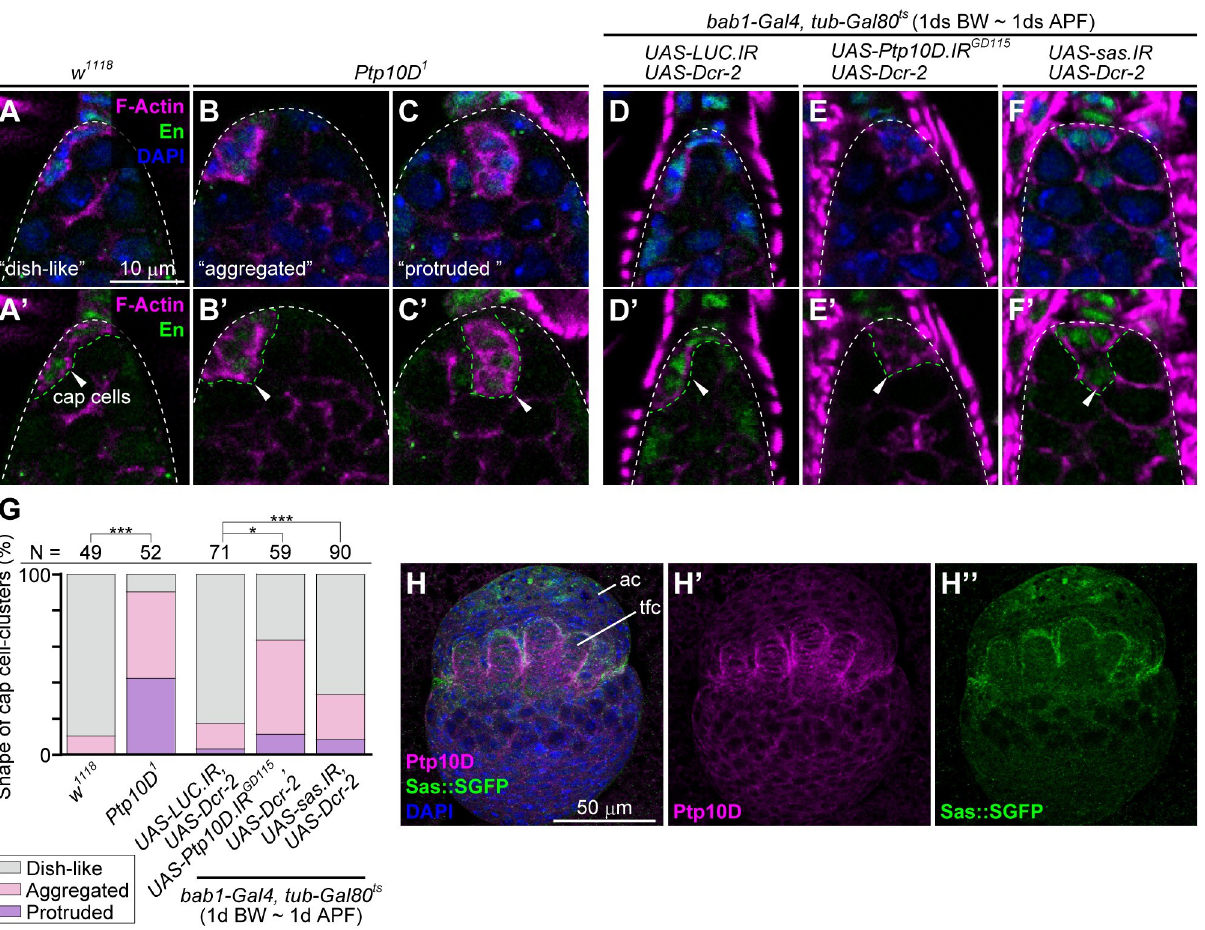
Fig 2. Loss of Ptp10D or sas in gonadal apical cells causes abnormal shaping of cap cell-cluster. (A-G) Proximal regions of female germaria without mating labeled with Phalloidin (magenta), anti-En antibody (green), and DAPI (blue). Proximal is to the top. (A-C) Germaria at 1 day after eclosion are shown. w 1118 homozygote with “dish-like” cap cell-cluster (A), and Ptp10D 1 homozygotes with “aggregated” (moderately abnormal) (B) and “protruded” (severely abnormal) (C) ones, respectively are shown as examples. (D-F) Germaria of indicated genotypes 2 days after eclosion that are treated with the temperature-sift (29˚C, 1d BW ~ 1d APF) are shown. Germaria with the abnormal cap cell-clusters are shown as examples. LUC . IR was used as a control. Dcr-2 was used to enhance RNAi efficiency. (A’-F’) Magenta/green channels of (A-F). White dashed lines in (A-F’) and green dashed line with arrowheads in (A’-F’) indicate outlines of germaria and cap cell-clusters, respectively. (G) 100%-stacked bar graph represents % of germaria with normal (gray), aggregated (pink), and protruded (purple) cap cell-clusters in indicated genotypes. Numbers (N) of samples observed and P-value ( *** P < 0.0001, * P < 0.01) for Fisher’s exact test are shown. (H) Female gonad of late wandering larva which contains two copy of Sas::SGFP transgene was labeled with anti-Ptp10D antibody (magenta), SGFP fluorescence/anti-GFP antibody (green) and DAPI (blue). The cell layer located at a opposite side of fat body adherent surface are shown. (H’ and H”) Magenta and green channels of (H), respectively. ac: apical cells, tfc: terminal filament cells. Scale bar in (H) is 50 μ m. Ptp10D is expressed ubiquitously and exhibits strong expression at the boundary between apical cells and terminal filament cells. Sas::SGFP shows higher expression in apical cells, especially in the most-distal region, compared to other cell types at basal half of gonad.